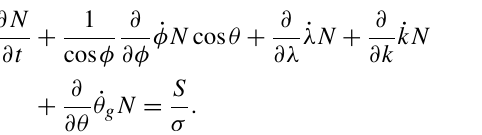
Table 1. Quality assessment of ECMWF winds with observed wind speeds for selected